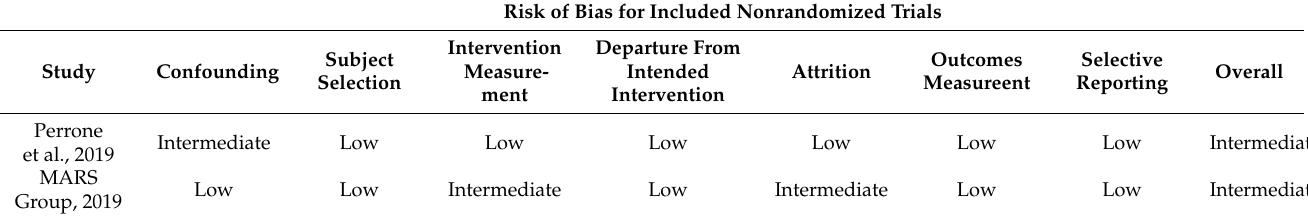
Table 3. Results of systematic quality appraisal for each nonrandomized study using the cochrane risk of bias assessment tool for nonrandomized Studies of